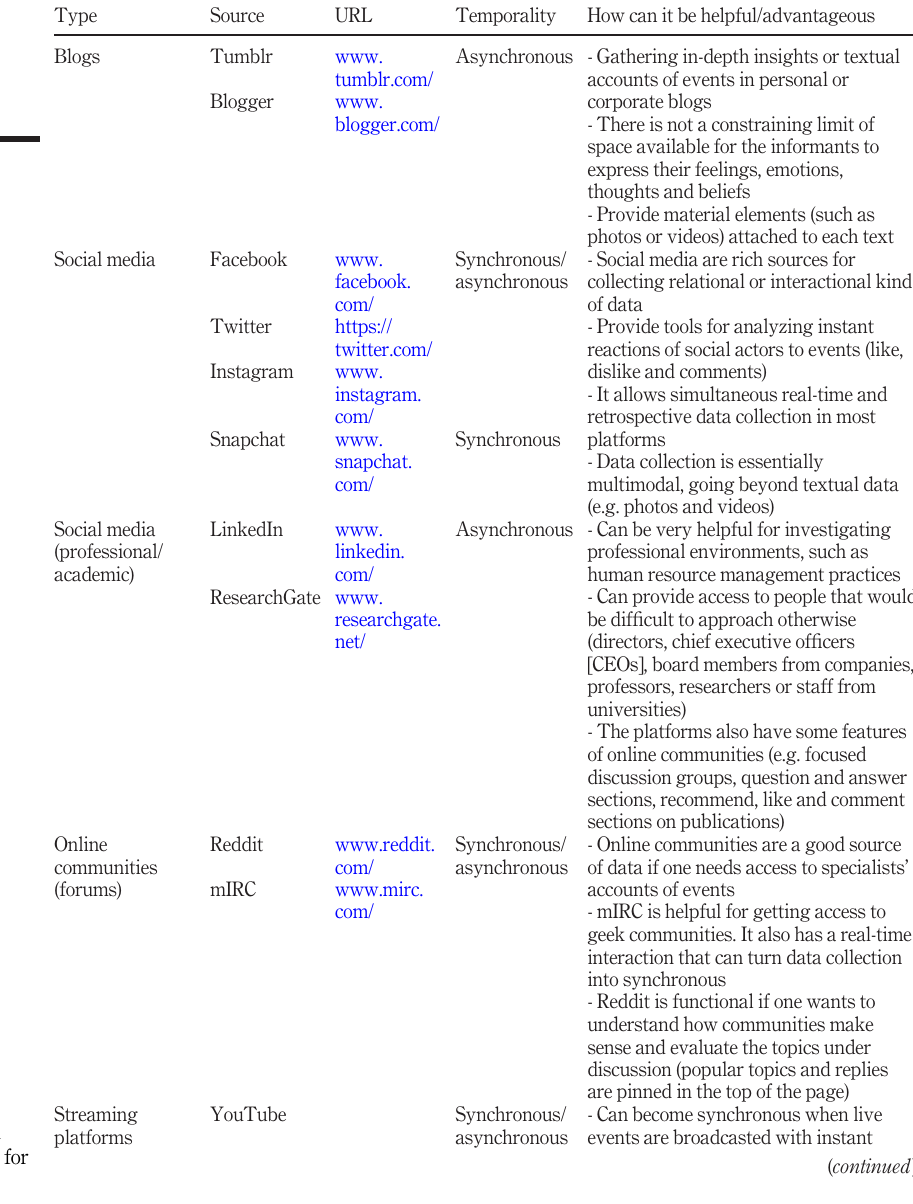
Table A1. Sample of useful online platforms for data